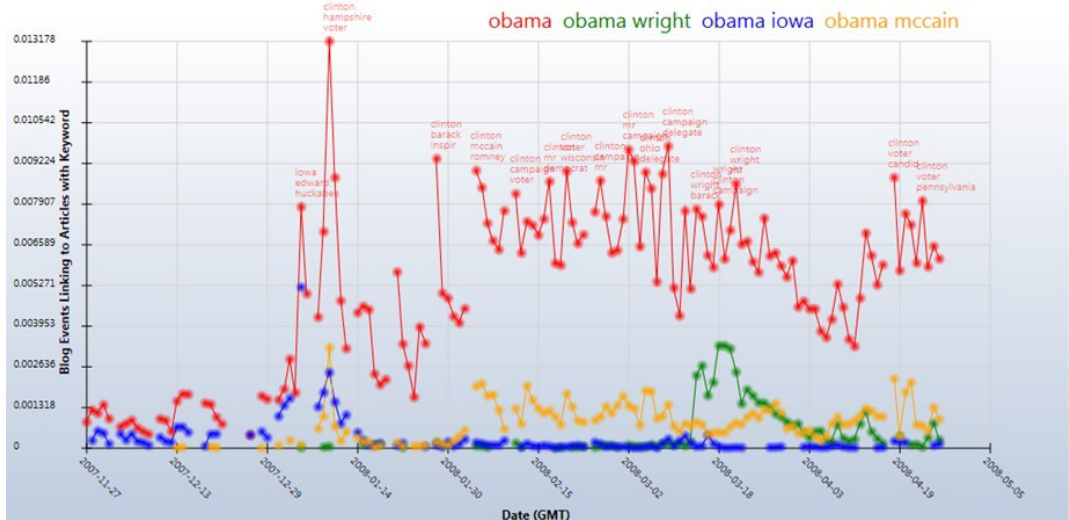
Figure 20. Fisher et al. show daily references to four US presidential candidates from 1 January to 26 March 2008. Time passes along the x -axis for each candidate; number of mentions of the term along the y -axis [43]. Image courtesy of Fisher et al.